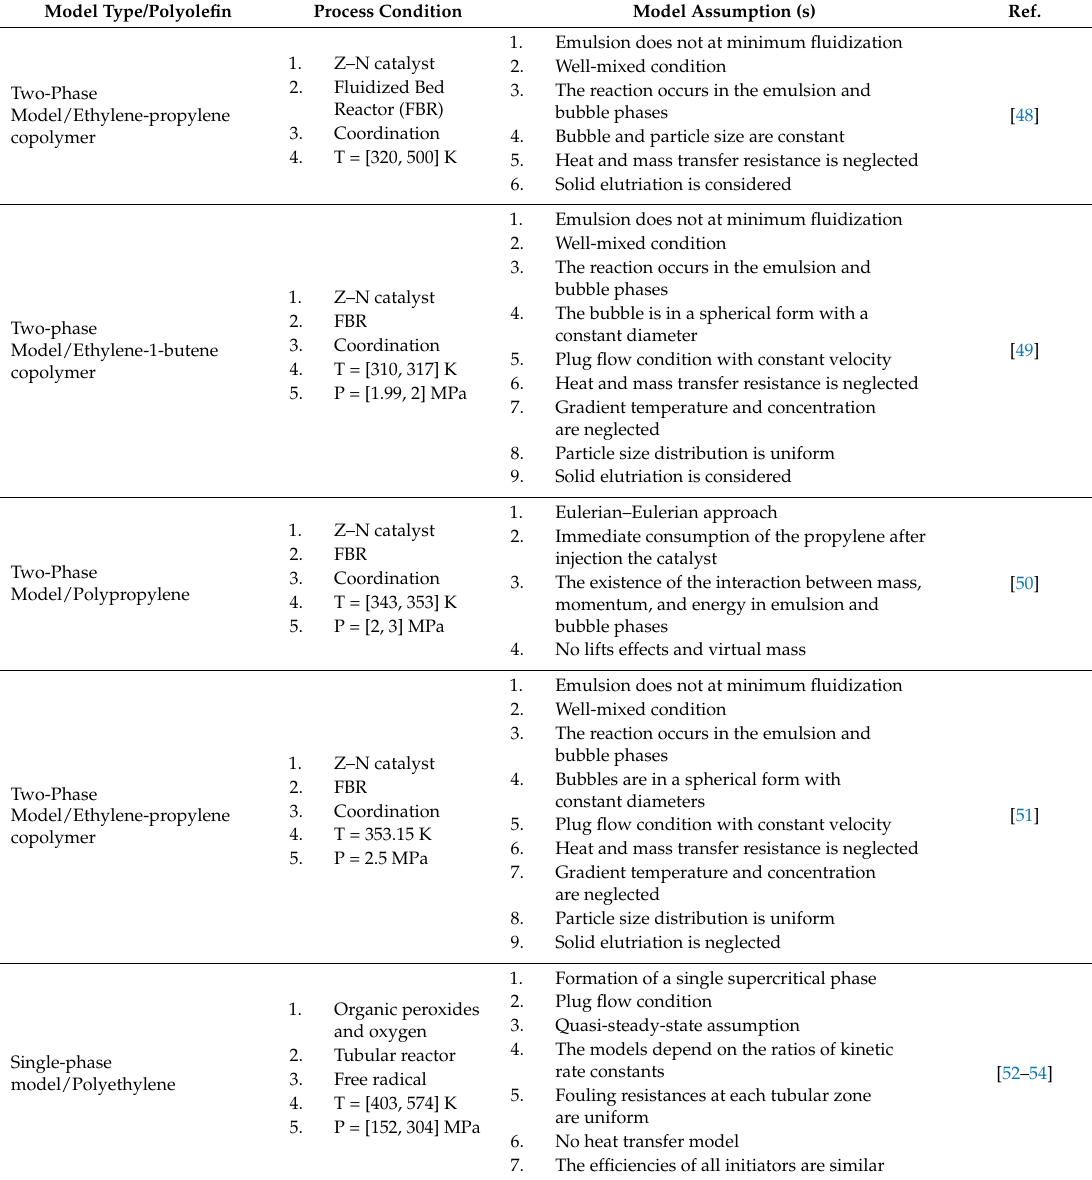
Table 2. Overview of implemented mathematical